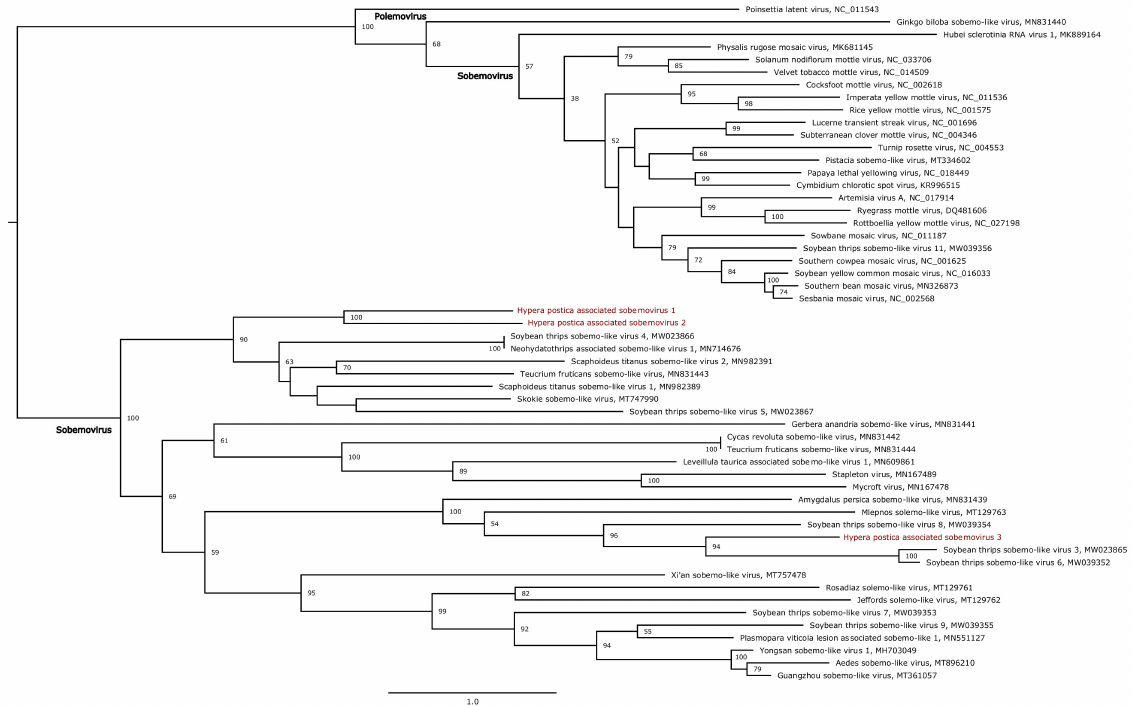
Figure 6. Maximum likelihood phylogenetic tree based on the RNA-dependent RNA polymerase protein of 54 sobe- moviruses. Viruses reported in this study are marked in red. The tree was mid-point rooted. Bootstrap values (1000 repli- cates) superior to 50% are indicated at each node. Scale bar corresponds to amino acid substitutions per